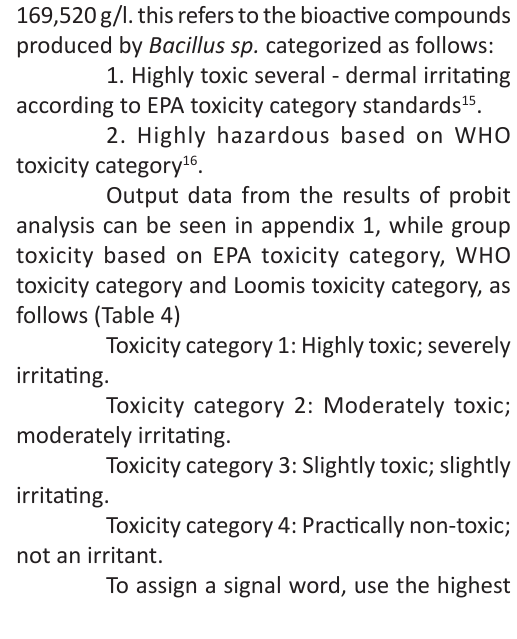
Table 5. WHO toxicity category 16